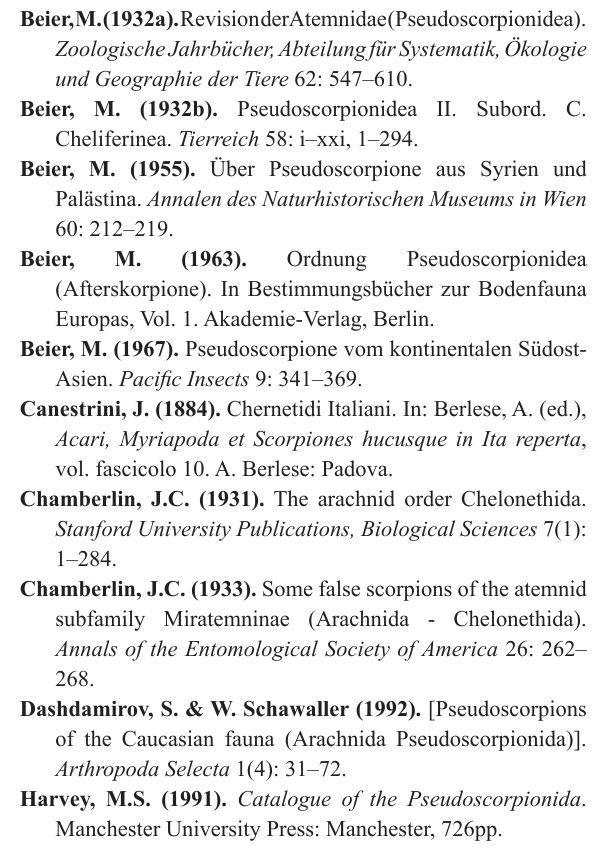
(Figs. 1K, 2K): the ejaculatory canal atrium (e) is not well-developed and may be aberrant in A. politus ; but in A. limuensis sp. nov., the atrium is normal, crescent-shaped on either side, and the distal end of the atrium is typically procurved. Moreover, the distal part (l) of lateral apodemes (a) in A. limuensis sp. nov. is larger than that in A. politus . However, they have many congeneric characters in the male genitalia (the letters refer to those of Figs. 1K and 2K): (1) the sclerotized distal part of lateral apodemes; (2) the presence of a hooked branch on proximal part of the lateral apodemes; (3) the presence of a rugose darker area on proximal part of the lateral apodemes; (4) the presence of a round projection on medial diverticulum and a prominent extension along the sagittal plane in M-shaped bulge (k) on two medial diverticula; (5) the long and proximally diverging lateral rods; (6) the distally joined long dorsal apodeme; and (7) the presence of bilobed anterior wall on the ventral